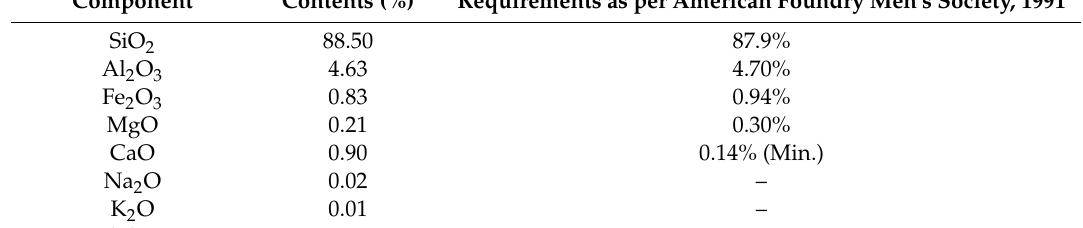
Table 2. Chemical composition (CC) of waste foundry sand.